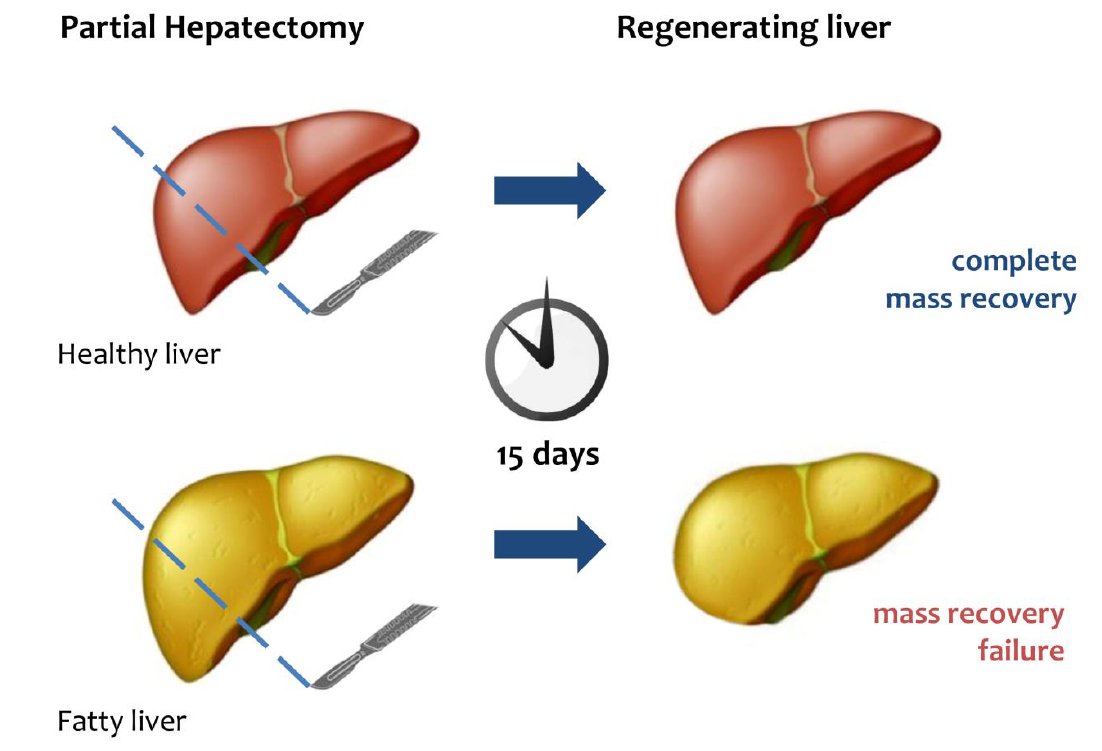
FIGURE 1: Liver regeneration failure in fatty liver. After PH, healthy liver can completely restore its mass and functional activity within 15 days. In fatty liver mass and functional recovery is